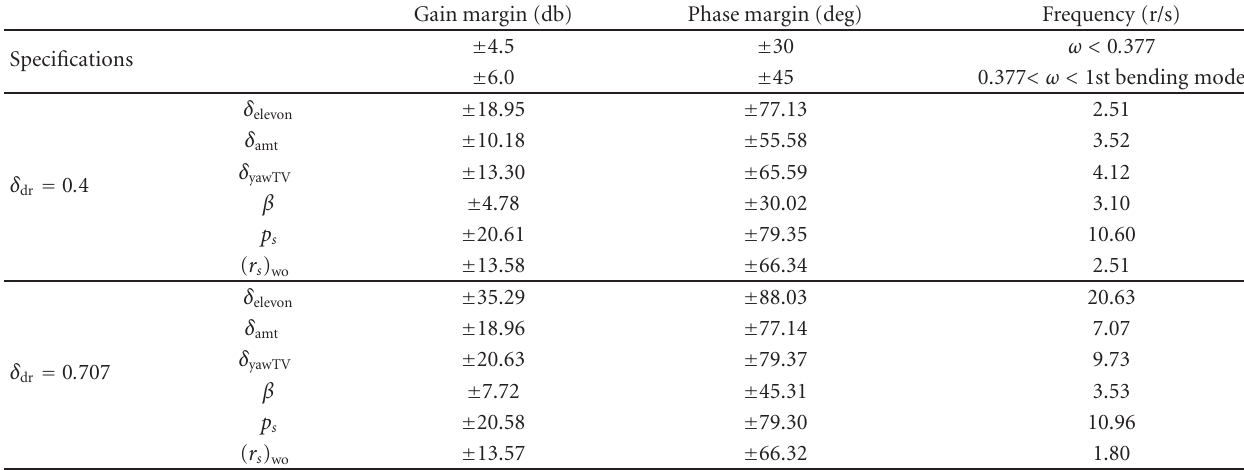
Table 4: Lateral disk gain and phase margins a